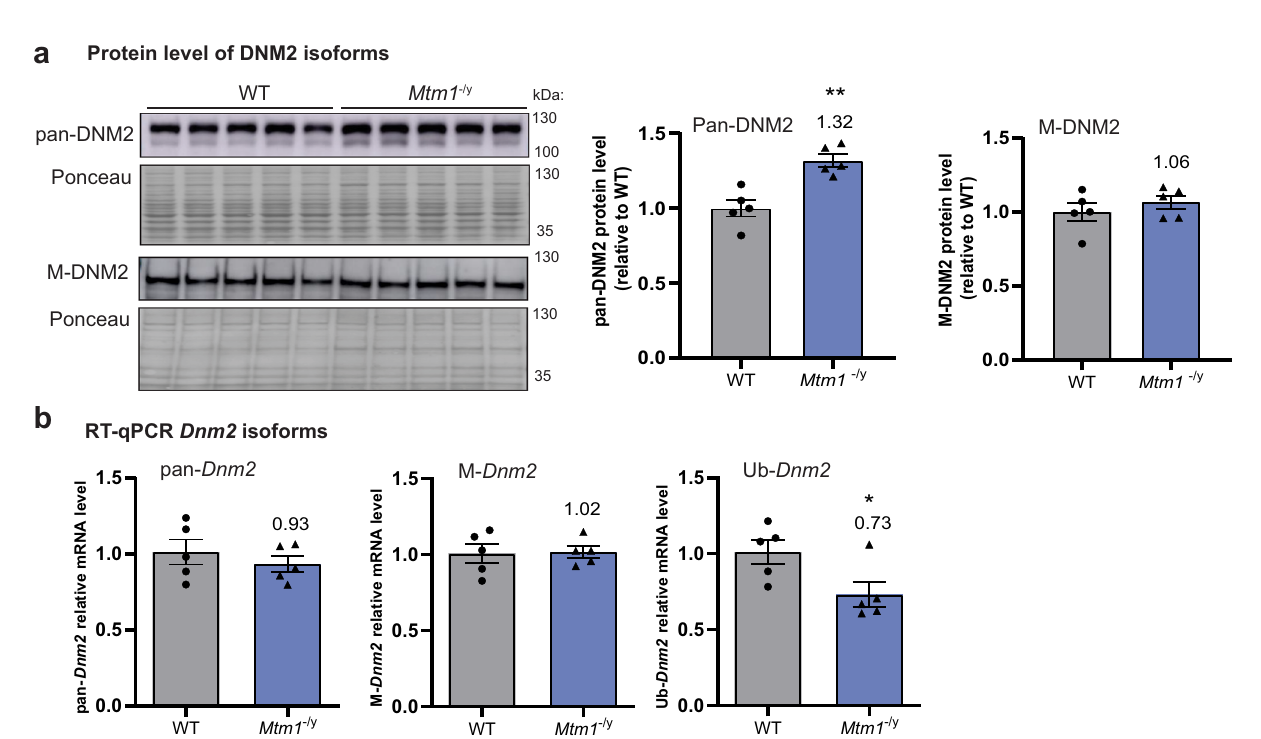
Fig. 4 | Increased pan-DNM2 protein levels in XLCNM do not correlate with increased level of M-DNM2. a Western blot with TA muscle protein extracts pro- bed with pan-DNM2 and M-DNM2 antibodies in sick 5-week-old Mtm1 − /y mice. Densitometer of the blot relative to WT is showed at the right ( n =5 mice/group, ** P =0.0018 by two-tailed unpaired t test). M-DNM2 was not found signi fi catively